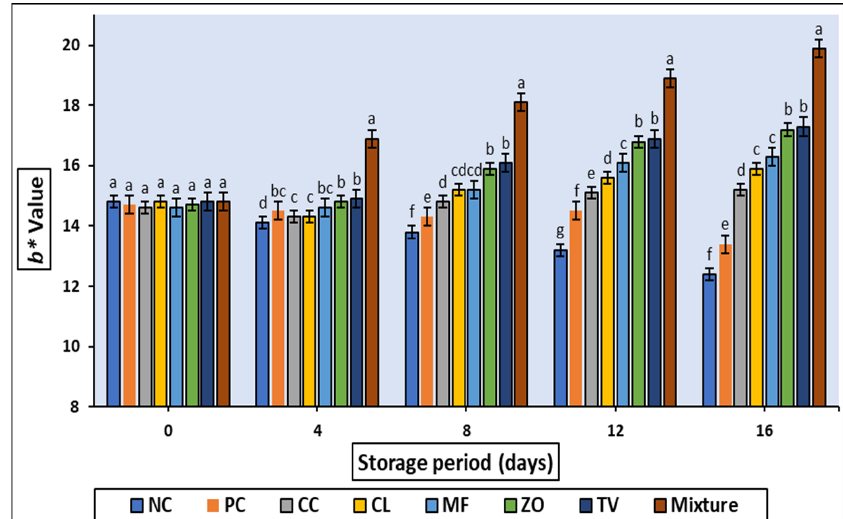
Figure 3. Changes in b* value of cold stored rabbit meat formulated with different aqueous plant extracts. Columns with different letters are significantly different ( p < 0.05).